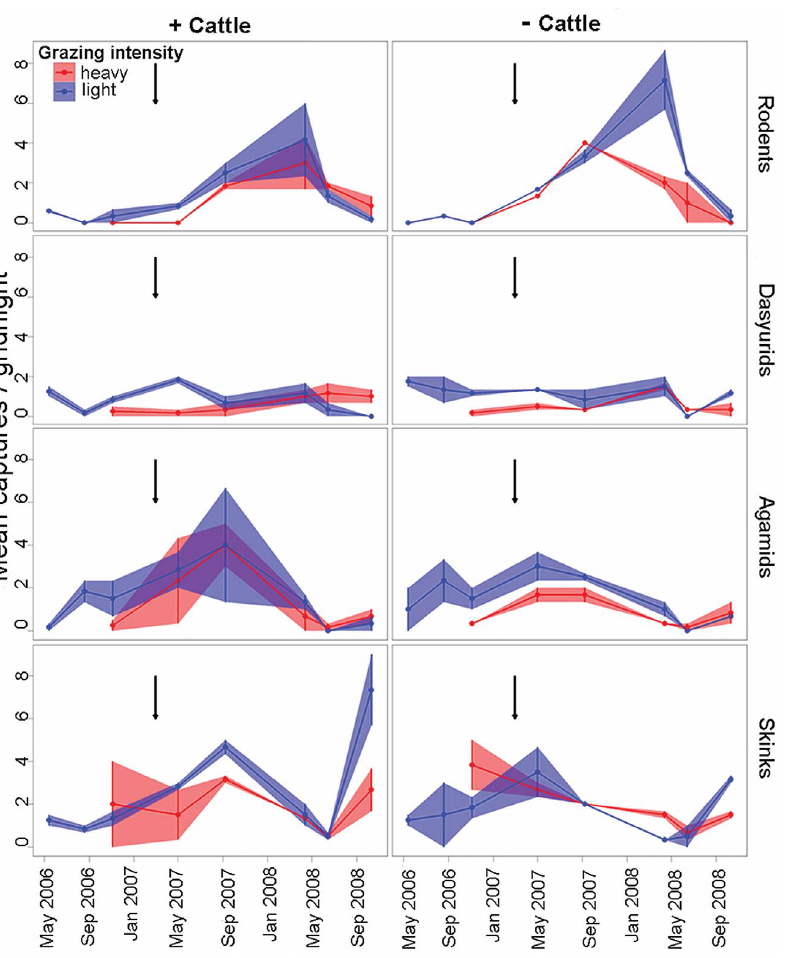
Figure 5. Captures (mean ± SE) of vertebrate groups under different grazing histories and cattle removal treatments. Captures are averaged per gridnight, vertebrate groups are rodents, dasyurids, agamids and skinks, historic grazing intensities are ‘light’ and ‘heavy’ and cattle removal treatments are ‘ + cattle’ and ‘ 2 cattle’. Only the trips from 2007 on, that is trips when balanced data sets were obtained (May 2007, September 2007, April 2008, June 2008 and October 2008), are used in the statistical analyses, but trips prior to 2007 are presented to give an overview of temporal trends. Arrows indicate heavy rainfall.